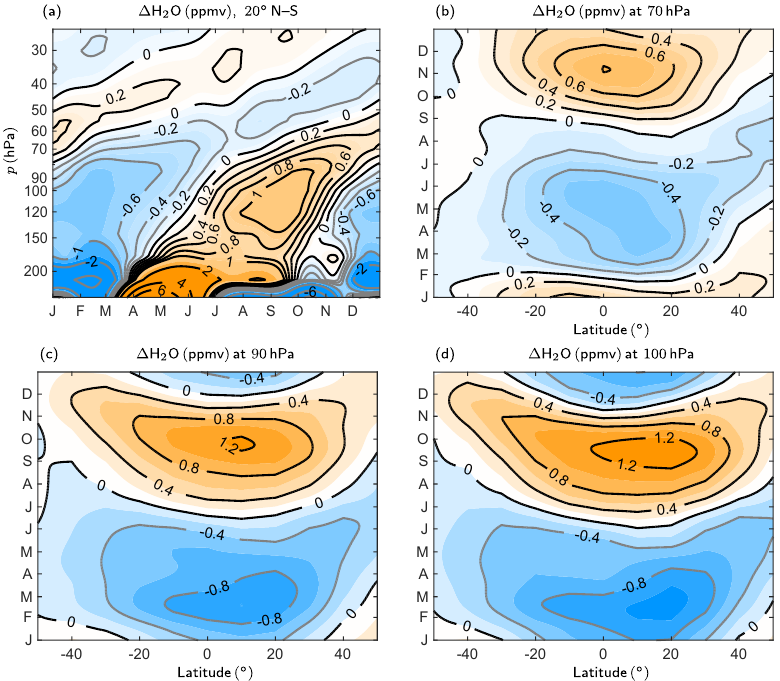
Figure 4. Water vapour volume mass mixing ratio (ppmv) from SWOOSH plotted as a difference from the annual mean (a) averaged over the region 20 ◦ N–20 ◦ S, (b) at 70hPa, (c) at 90hPa, and (d) at 100hPa.